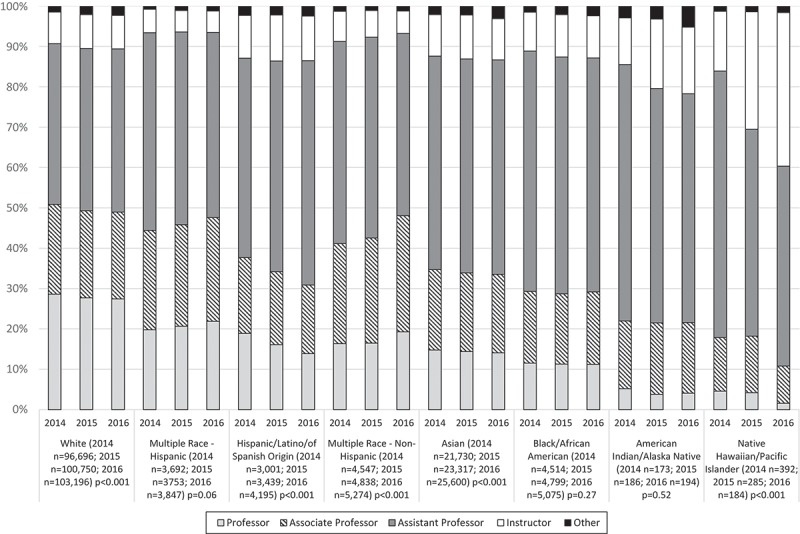
Medical school facility rank according to race/ethnicity 2014–2016.